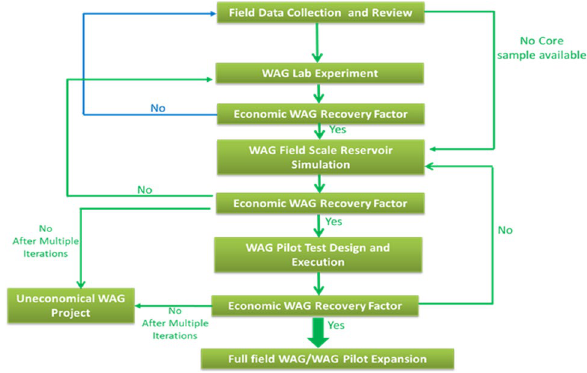
Fig. 1 Typical workflow for big scale WAG project